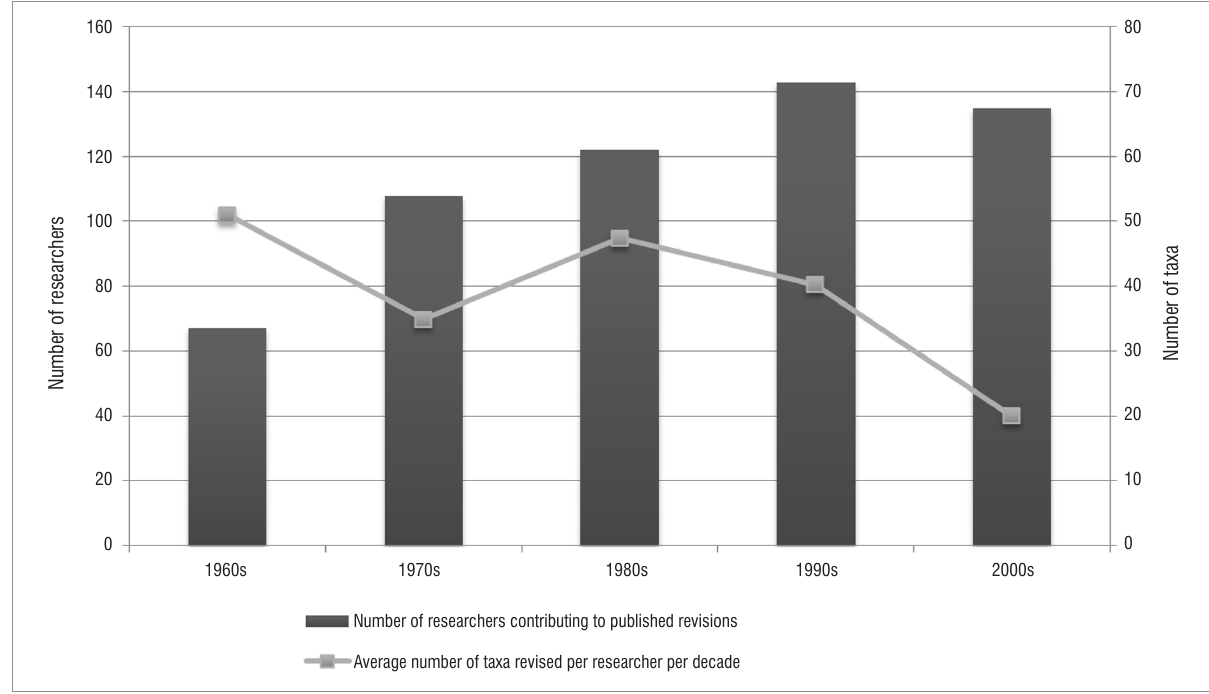
Figure 3: Changes in revisionary productivity over the past 50 years reflected as the number of individual researchers contributing to published revisions relative to the number of taxa (species and subspecific ranks) revised per researcher per